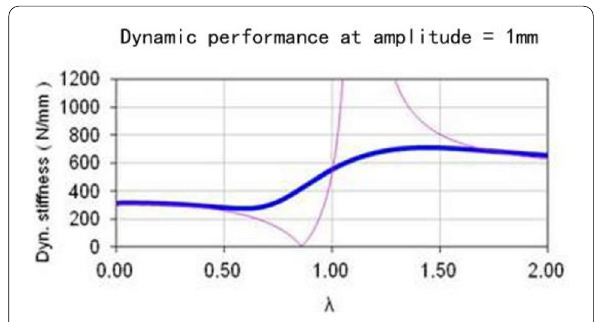
Figure 3 Dynamic stiffness dimensionless simulation